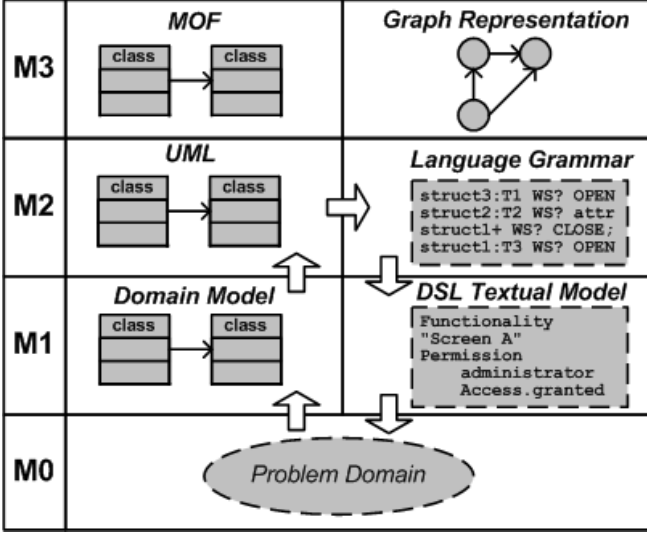
Fig.1. Model Transformation